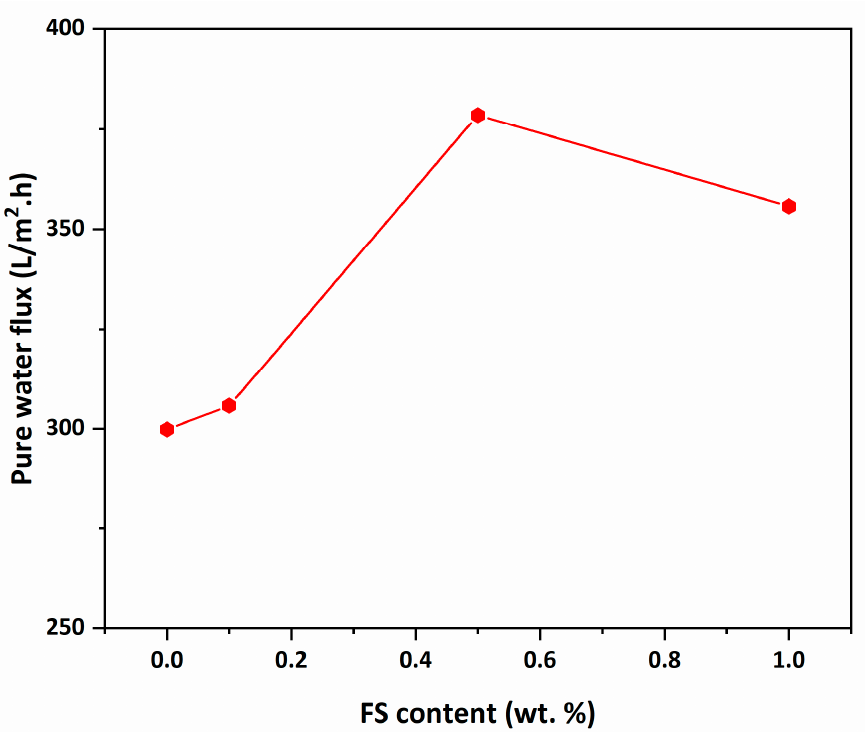
Figure 8. Pure water flux of PAN/FS membranes under 3 bar pressure.